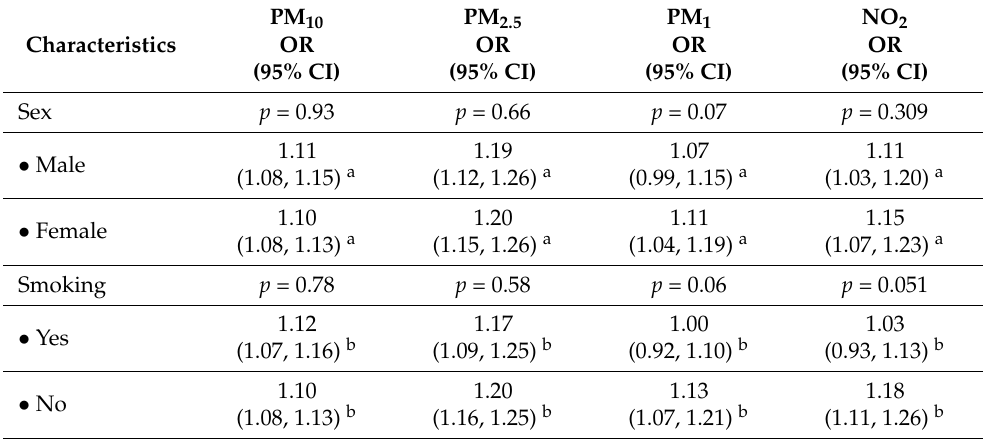
Table 3. Stratified analysis of the probability of increased risk of CVD associated with 10 µ g/m 3 increase in 3 year moving averages in each pollutant